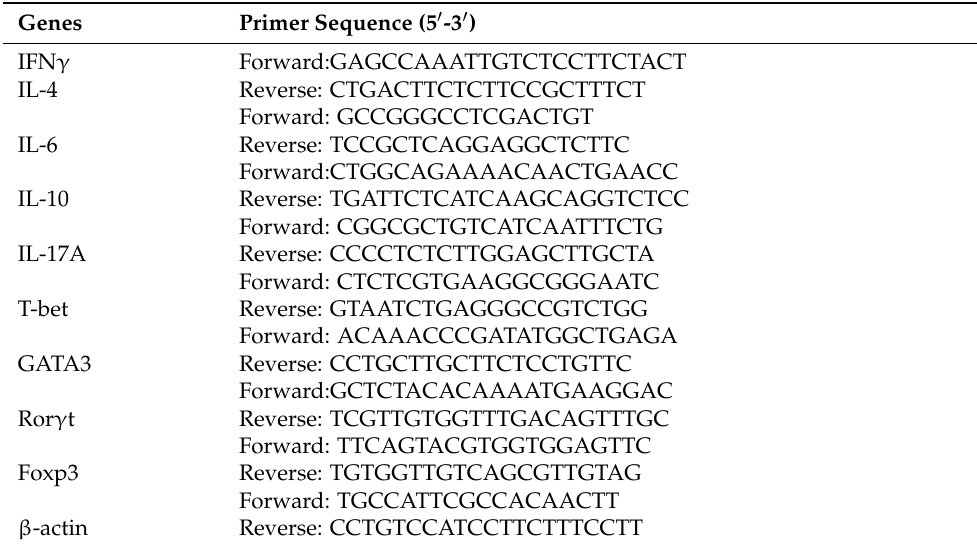
Table 1. Specific primers for fluorescence quantitative